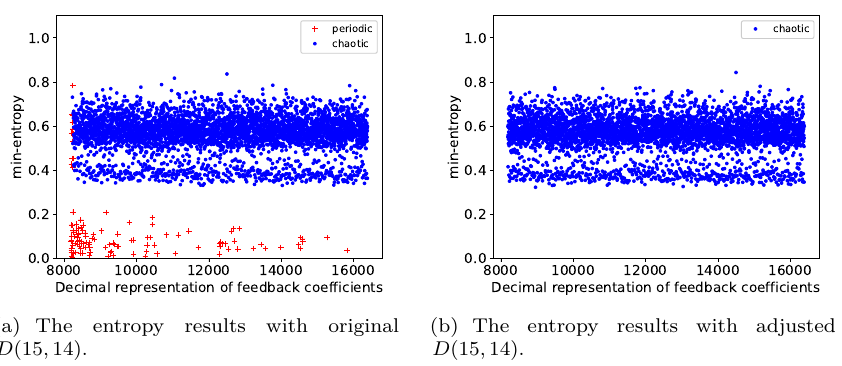
Figure 22: The measured entropy results for the GARO with f 14 = 1 and 15 cascaded inverters.